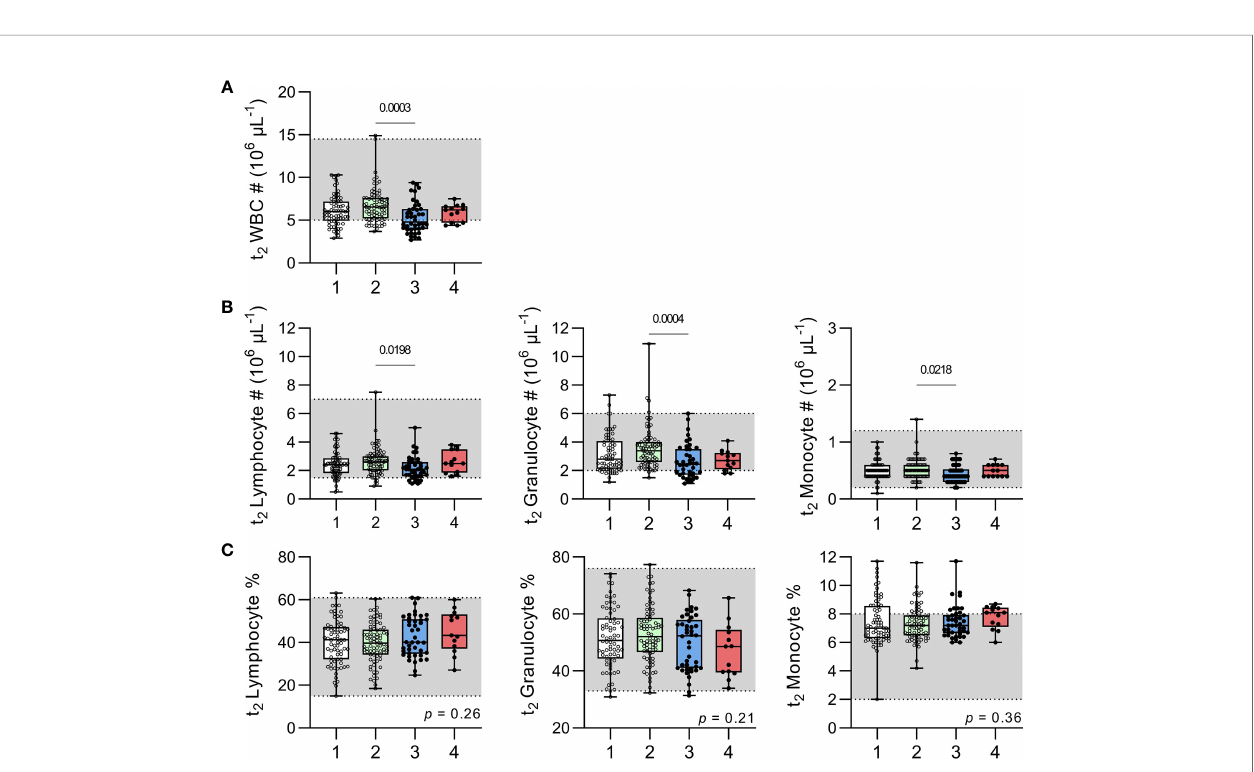
FIGURE 5 | Leucocyte numbers and proportions in uninfected children and children with resolved or persistent P. falciparum infections. Complete blood counts were performed on venous blood for (A) total white blood cell (WBC) numbers (#). Subpopulations of lymphocyte, granulocyte and monocytes enumerated and shown as total number (B) or percentage (C) . Grey shadow boxes represent normal paediatric reference ranges (20). Data shown as box plots with min/max whiskers where dots represent each participant. Signi fi cant p values shown, calculated using a Kruskal-Wallis rank sum test followed by a post-hoc Dunn ’ s test with Bonferroni adjustment for multiple comparisons. Group IDs: #1 ‘ Controls ’ , #2 ‘ Anaemic ’ , #3 ‘ Resolved ’ , and #4 ‘ Chronic ’